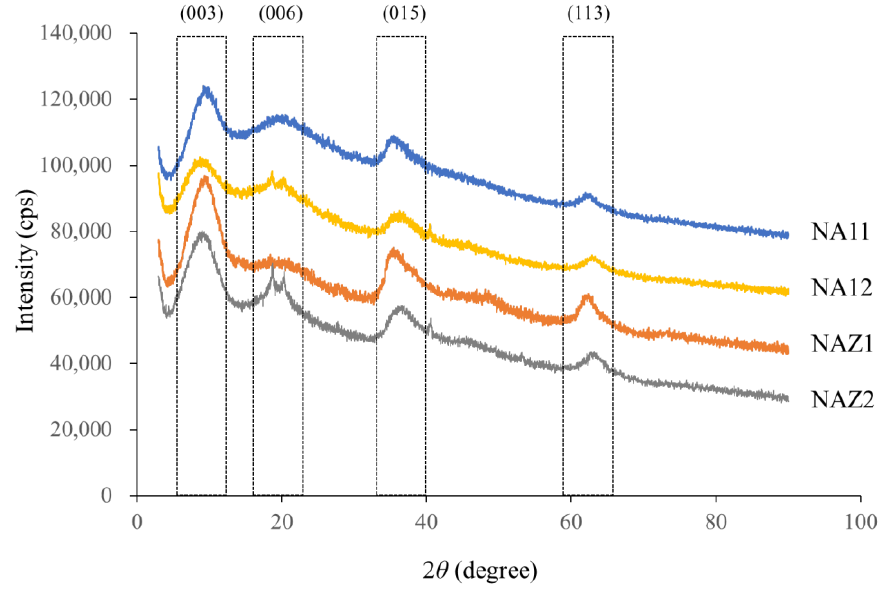
Figure 2. XRD patterns of adsorbents.